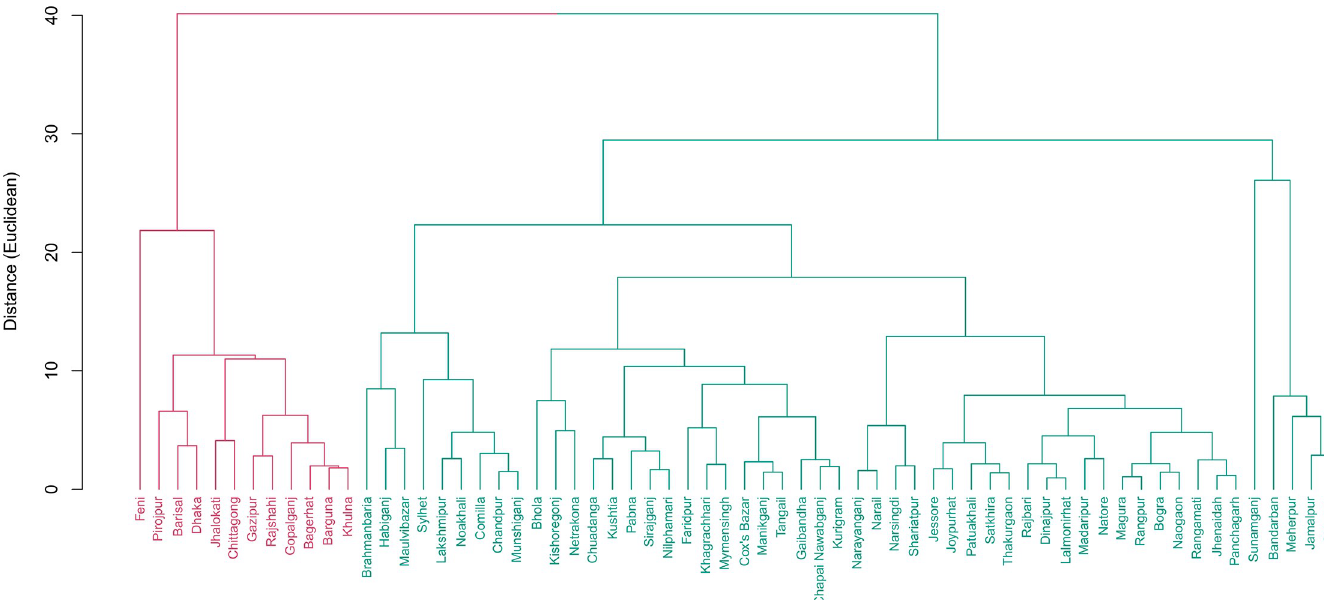
Fig 1. Cluster of districts based on demographic indicators. Two clusters were found based on demographic indicators. Cluster 1 includes 12 districts while 52 districts were in cluster 2. Districts in cluster 1 have 10% point higher literacy rate than the national rate of 63%.